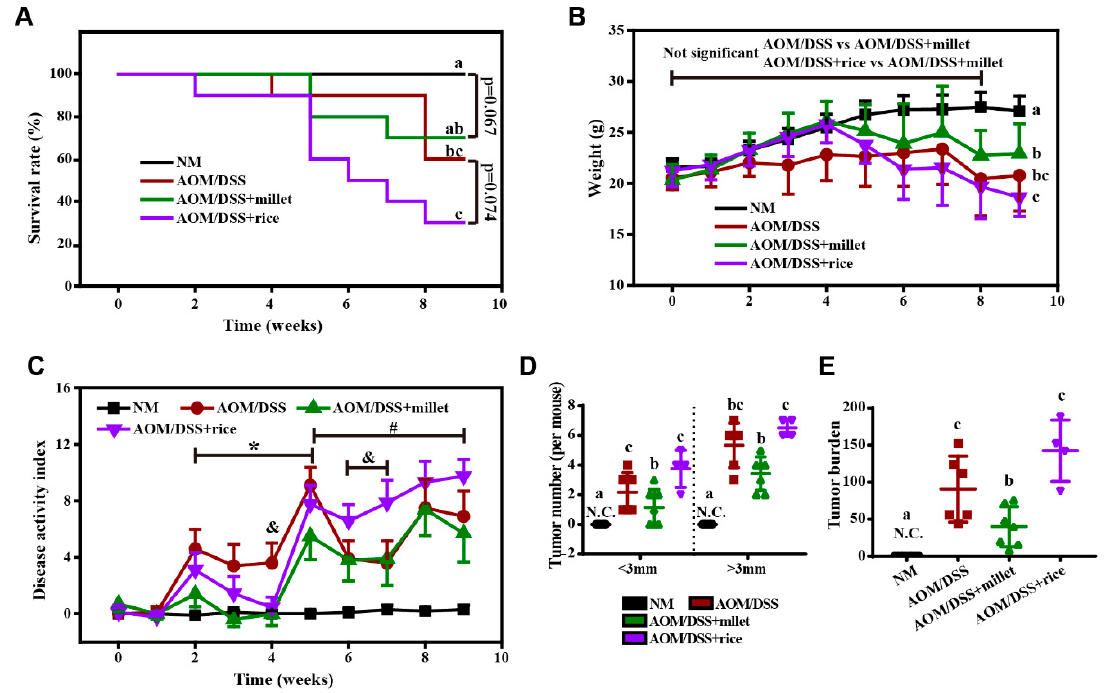
Figure 2. General observation of the mice in NM, AOM/DSS, AOM/DSS + millet and AOM/DSS + rice groups. ( A ) Survival rate; ( B ) Weight; ( C ) Disease activity index (DAI); ( D ) Tumor number (per mouse); ( E ) Tumor burden (total tumor volume per mouse in mm 3 ). ( A ) Survival rate was analyzed